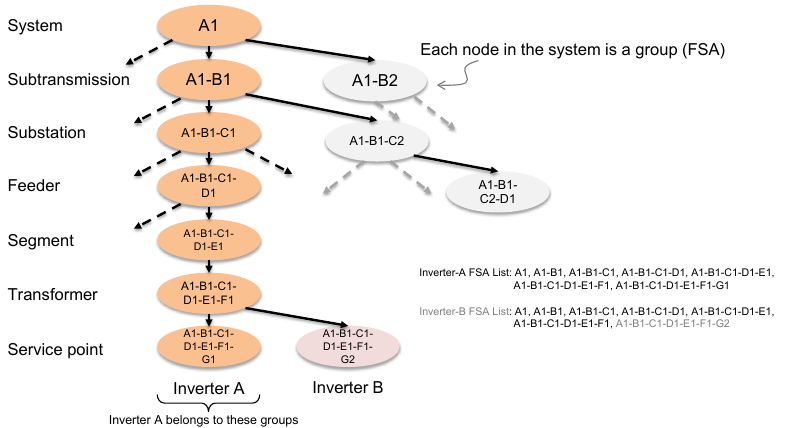
Figure 20. Hierarchical view of DERs. Adapted from SunSpec Alliance IEEE 2030.5/CA Rule 21. Individual DERs are referred to by the device UUID from within the software, pro-